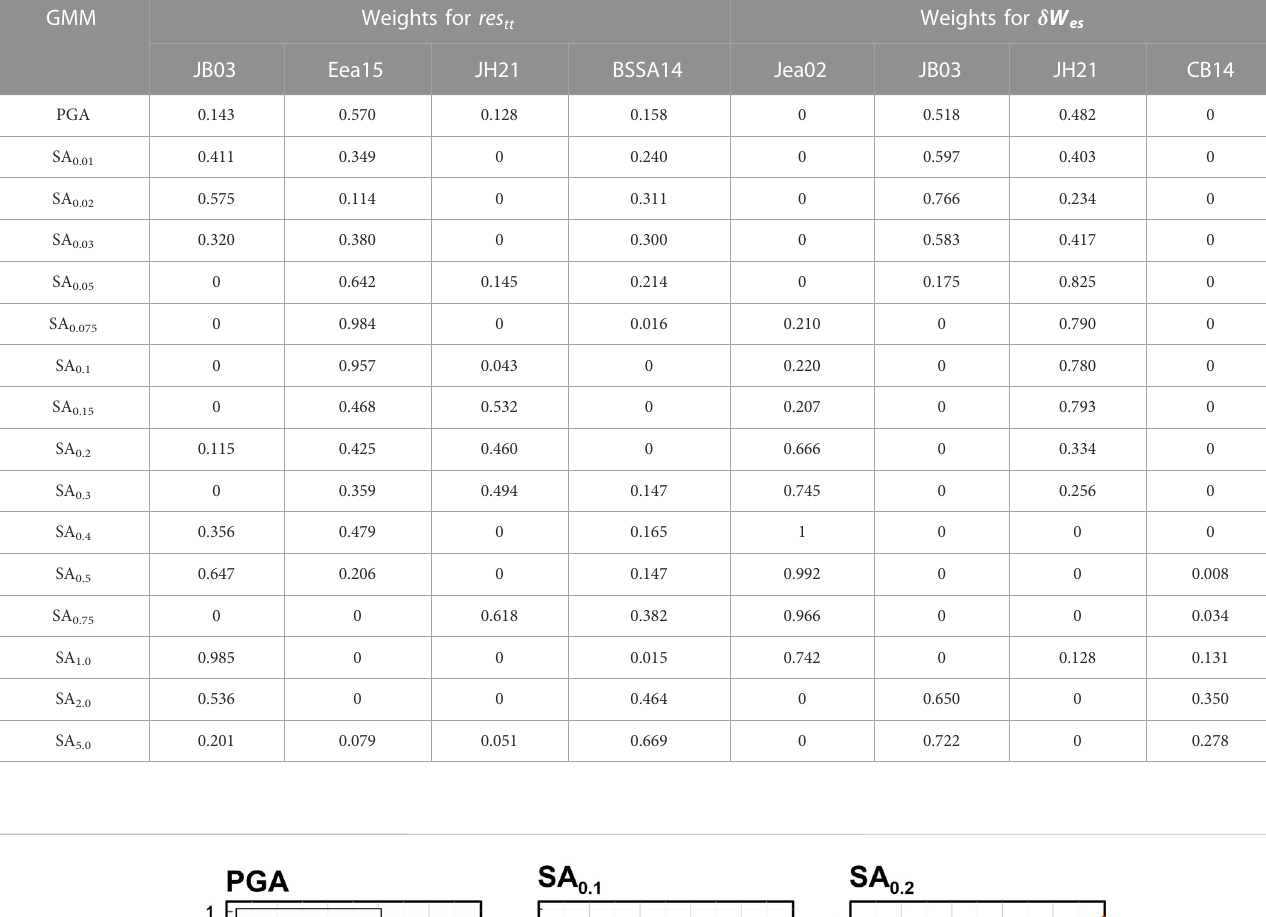
TABLE 5 Suggested weights of four GMMs for res tt and δ W es per IM.